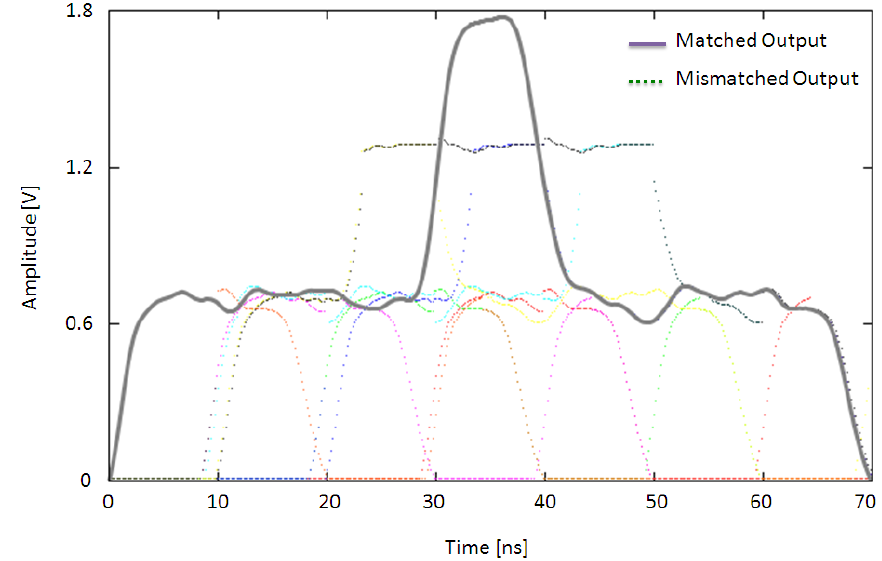
Figure 8. Measured correlation outputs for all possible combinations of input bit patterns. The solid line indicates the output for a matched bit pattern whilst the dotted lines are for mismatched bit